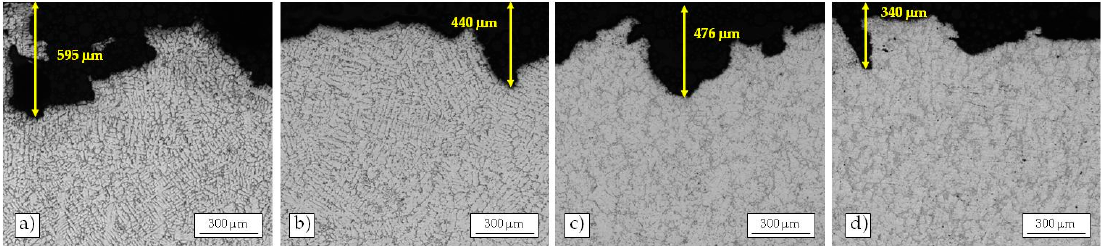
Figure 11. Cross-sectional micrographs of NUST as-cast ( a ) and NUST T6 ( b ); UST as-cast ( c ); and UST T6 ( d ) samples near severe erosion regions after 8 h of cavitation erosion.